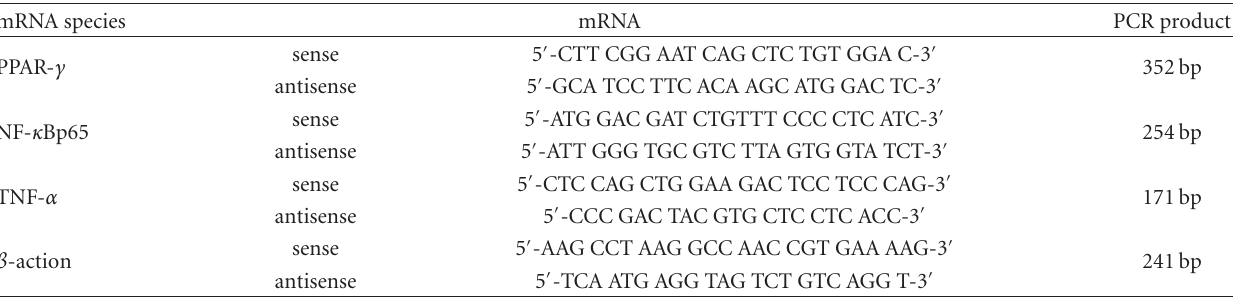
Table 1: Oligonucleotide of primers of target